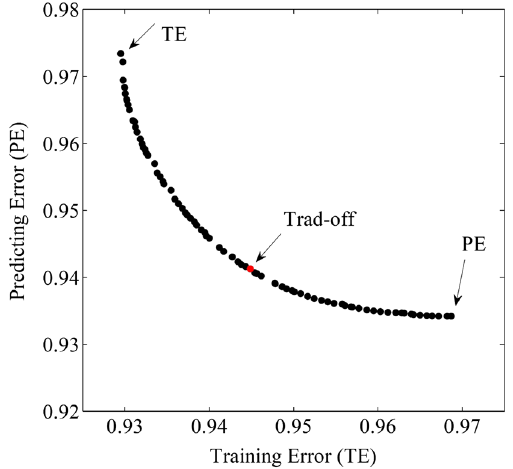
Fig. 4 Mutation scale factor ( F ) based on proximity to optimal solu- tion in Pareto front (Azimi et al. 2016) Fig. 5 Pareto curve of training error and prediction